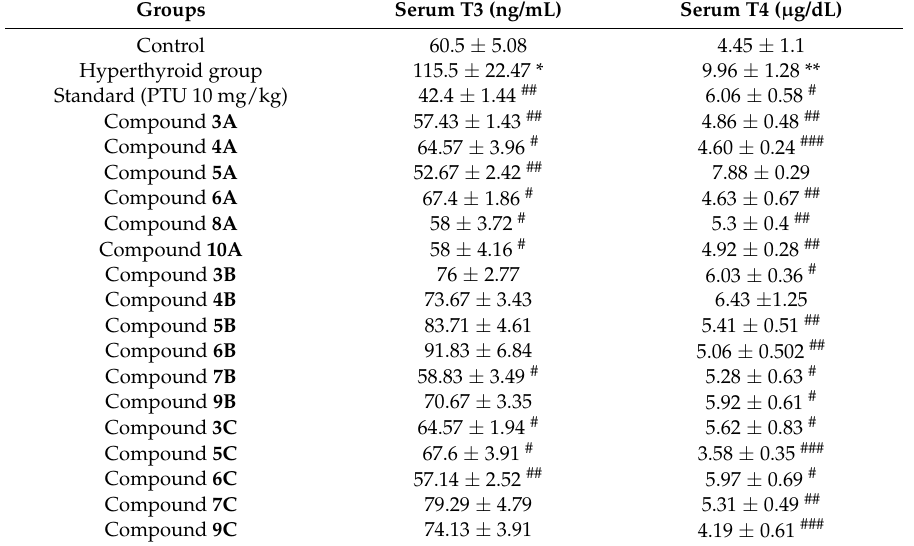
Table 1. Effect of various treatments on the mean serum levels of T3 and T4 in